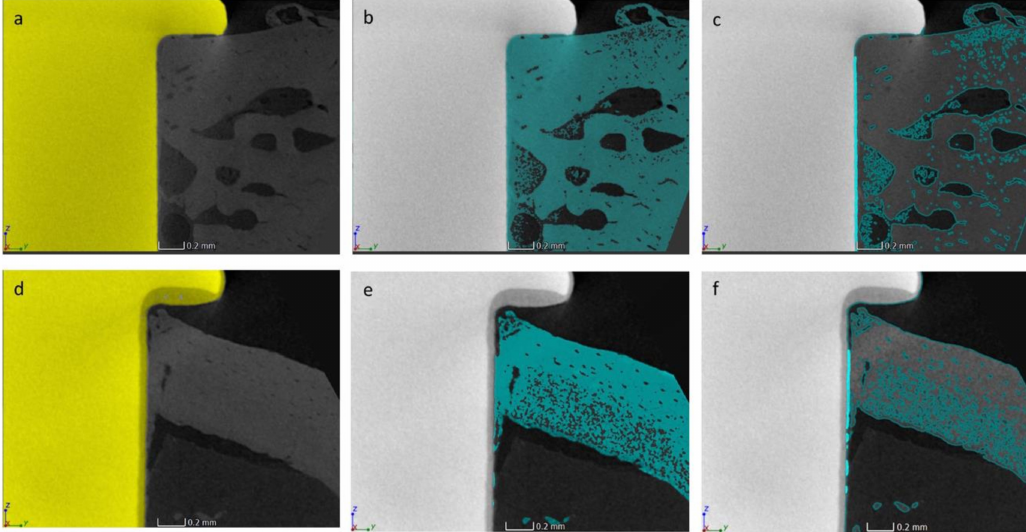
Figure 5. Representative micro-CT transverse cross-sectional views of the uncoated ( a – c ) and the sphene-coated ( d – f ) Ti implants inserted in the rat femur after 28 days of healing with the indicated selection of the ROI I and ROI I + C in yellow ( a , d , respectively) and ROI B in light blue ( b , e ). ROI INT ( c ) and ROI INTc ( f ) are shown indicated in fluorescent